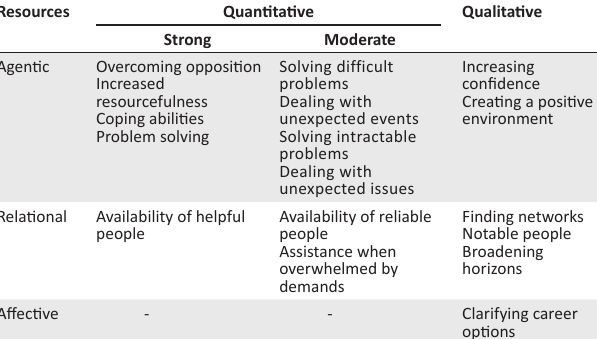
TABLE 9: Results